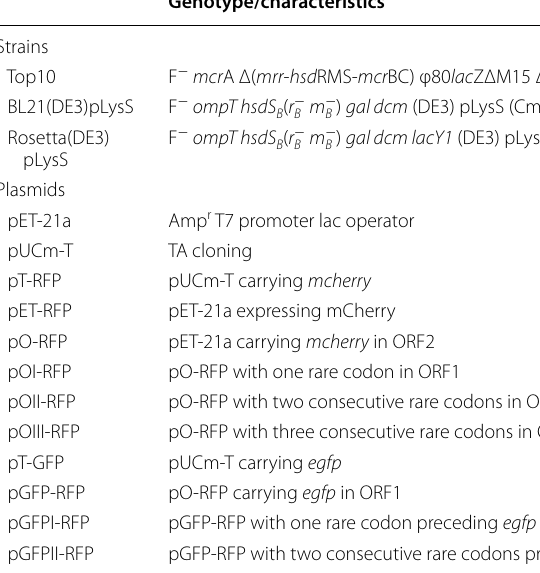
Table 1 Bacterial strains and plasmids used in this study